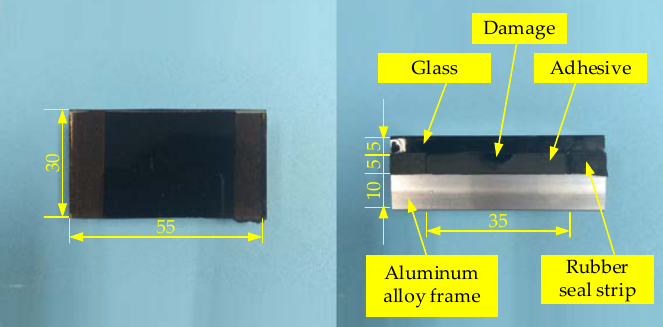
Figure 12. Sample for thermal wave detection of glass-curtain wall bonded structure damage.